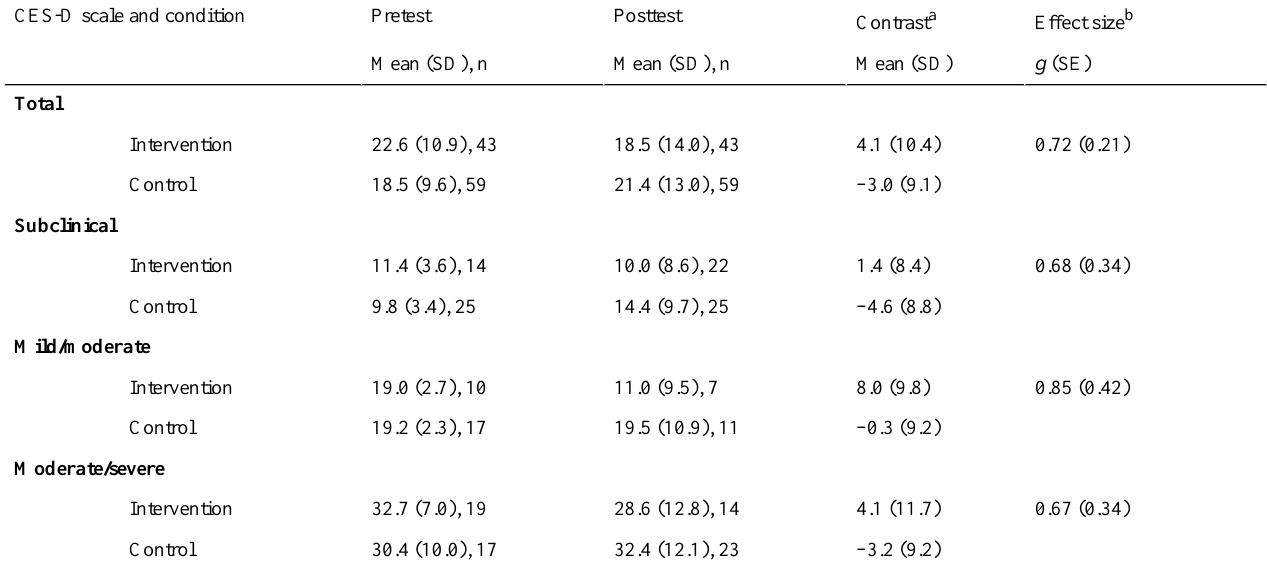
Table 3. Completers between-group effect size (Hedges’ g ) for depression level as measured by the Center for Epidemiologic Studies Depression Scale (CES-D).